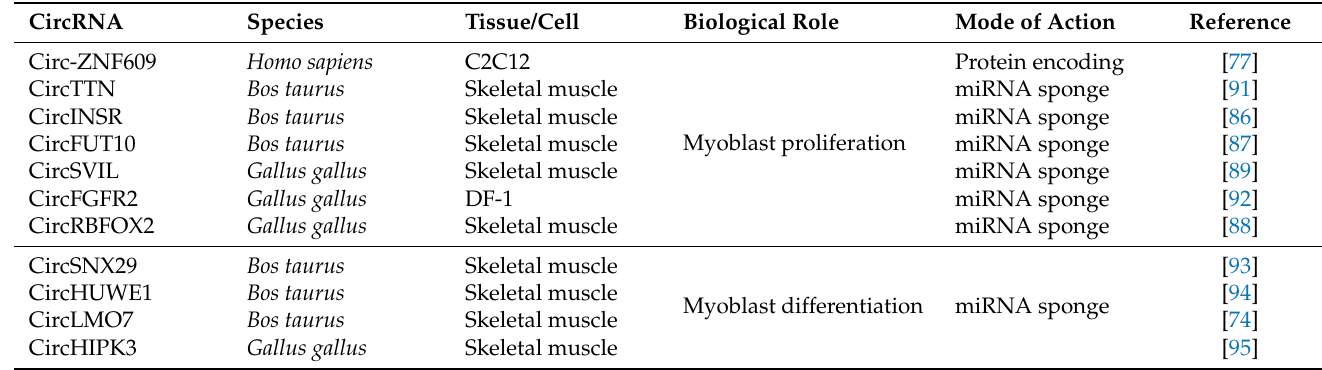
Table 2. A summary of circRNAs involved in skeletal muscle growth, showing their name, species, and tissue of origin, along with their biological roles and modes of